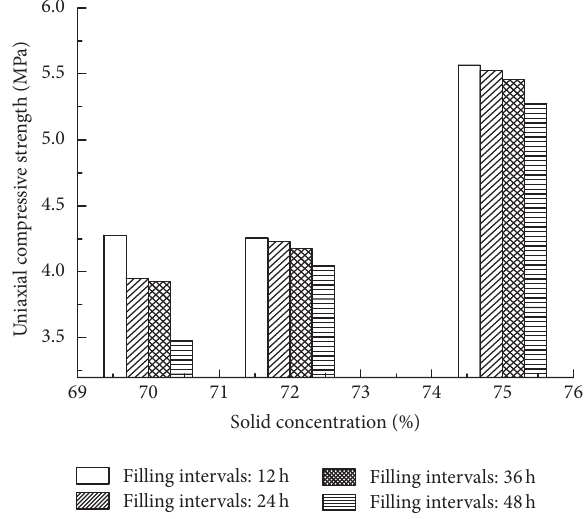
Figure 6: Relationship between concentration and UCS